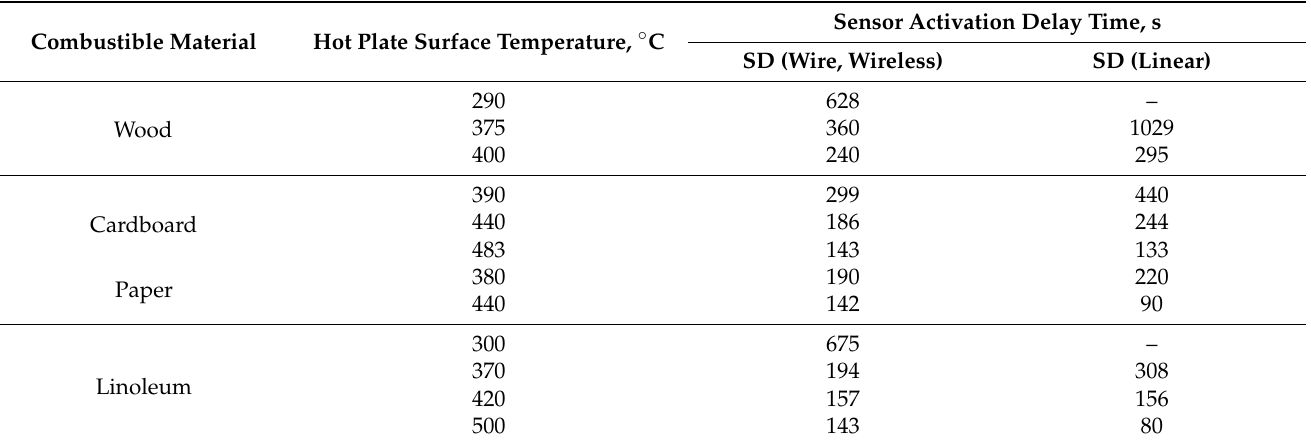
Table 3. SD activation delay times when varying the hot plate surface temperature under imitated conditions of unsafe operation of heating equipment without fire suppression.